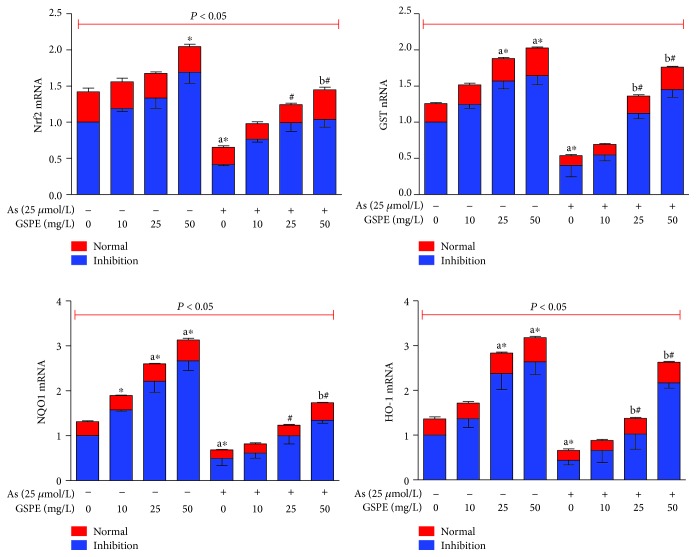
mRNA expression of the Nrf2 pathway in Nrf2-suppressed cells (mean ± SD, n = 3). L-02 cells were treated with arsenic and/or grape seed procyanidin extract (GSPE) for 24 h. ∗In Nrf2 normal cells versus the control group, P < 0.05; #in Nrf2 normal cells versus the arsenic group, P < 0.05; ain Nrf2 inhibition cells versus the control group, P < 0.05; bin Nrf2 inhibition cells versus the arsenic group, P < 0.05. In Nrf2-suppressed cells, GSPE could still mitigate arsenic-induced decrease in mRNA expression of Nrf2 and downstream genes; however, its effect was weaker than that in Nrf2 normal cells.